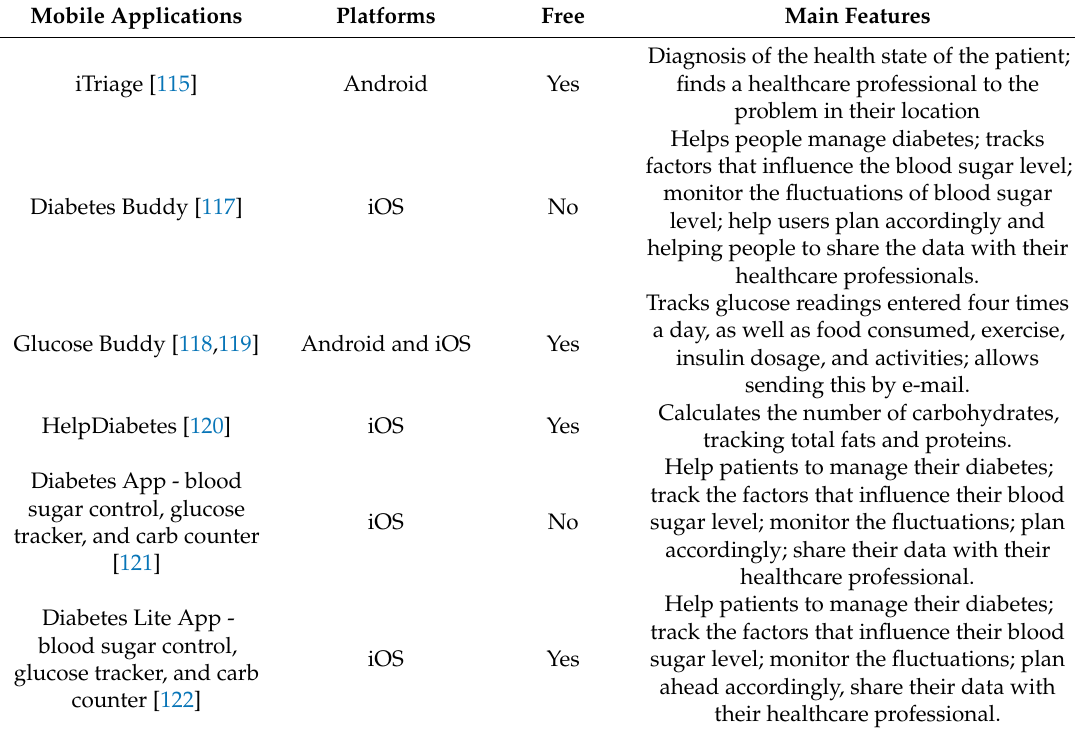
Table 2. Mobile health applications related to diagnosis and